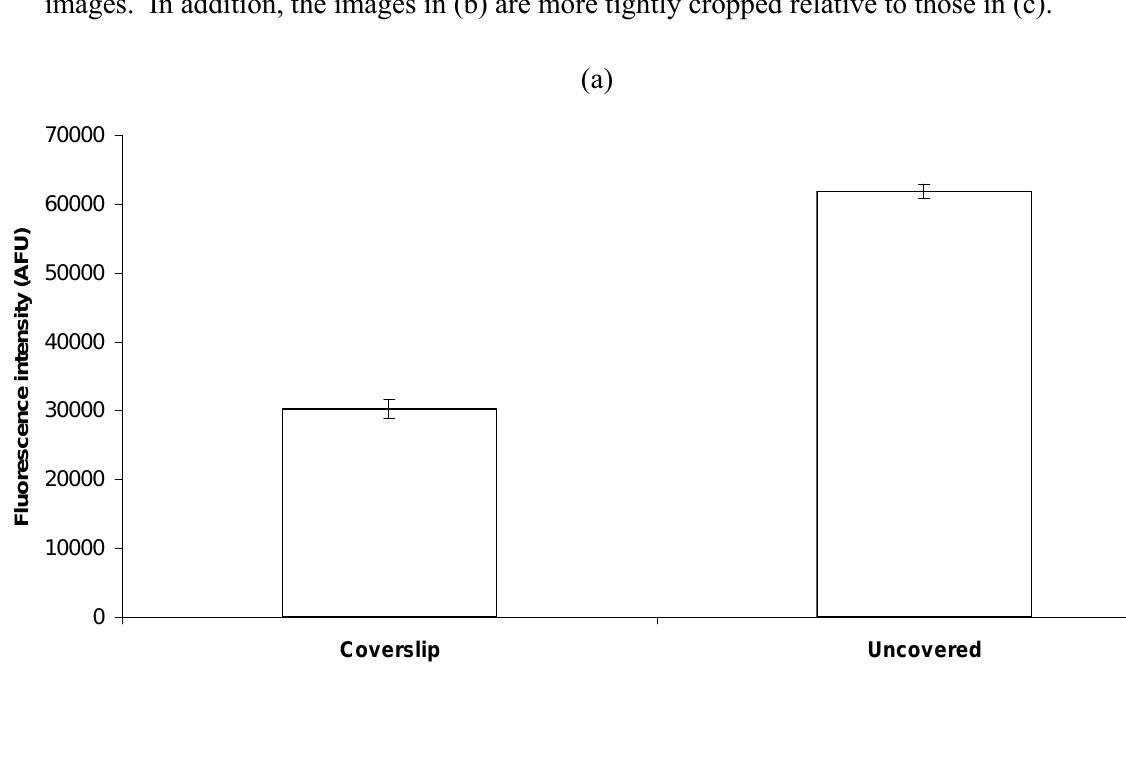
Figure 2. Bacterial capture as affected by the use of a coverslip. (a) Detection of 4.7 x 10 8 cells/mL (with 1 ng capture antibody/nL spots) exhibited lower AFU (arbitrary fluorescence units, background corrected) values with the use of a coverslip versus a hydrophobic barrier. (b) Fluorescence microscopic images of covered (left) and uncovered (right) microarray